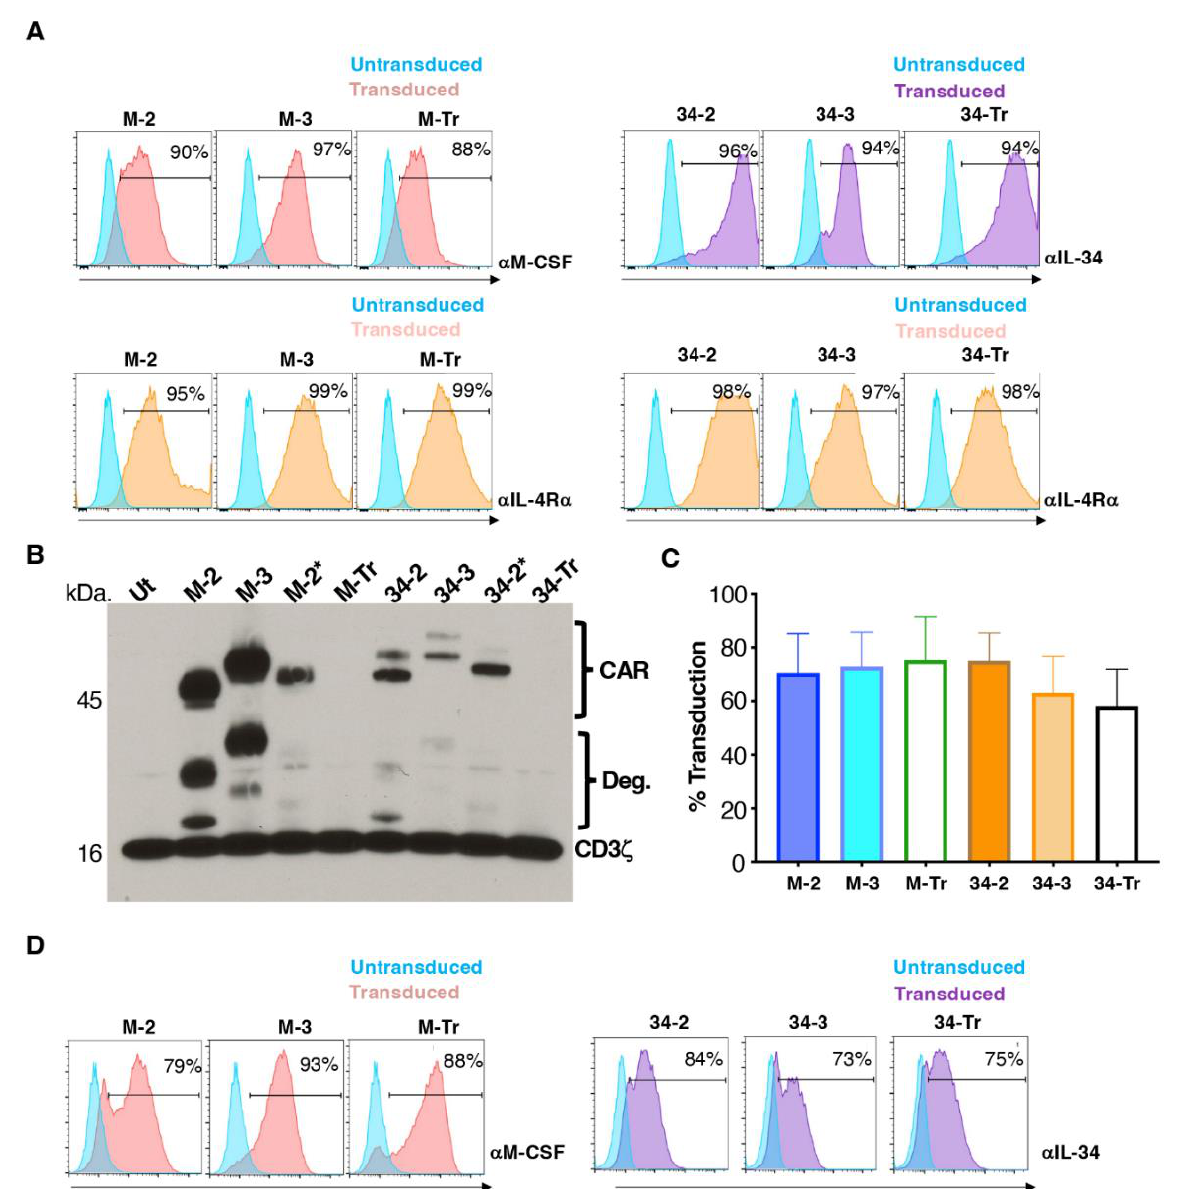
Figure 2. Engineering of human T-cells to express M-CSFR-specific CARs. ( A ) Cell surface expression of CARs and 4 αβ receptor on 293VEC-RD114 TM retroviral packaging cells. Similar findings were obtained using PG13 retroviral packaging cells. ( B ) A Western blot was prepared under reducing conditions using protein lysates derived from the indicated CAR T-cell populations. Following incubation with an anti-CD3 ζ antibody, endogenous CD3 ζ chain and CAR-associated bands are highlighted. Endodomain truncated (Tr) CARs serve as negative controls. Deg. indicates presumed CAR degradation products. M-2* and 34-2* contain a T2A peptide fused to the CAR C-terminus, in contrast to all other CARs. ( C ) Cell surface levels of the indicated CARs in retrovirus transduced human T-cells following IL-4-mediated enrichment (mean ± SD, n = 10). ( D ) Representative examples of expression of M-CSFR-specific 2G, 3G and truncated CARs in human T-cells. Analysis was performed by flow